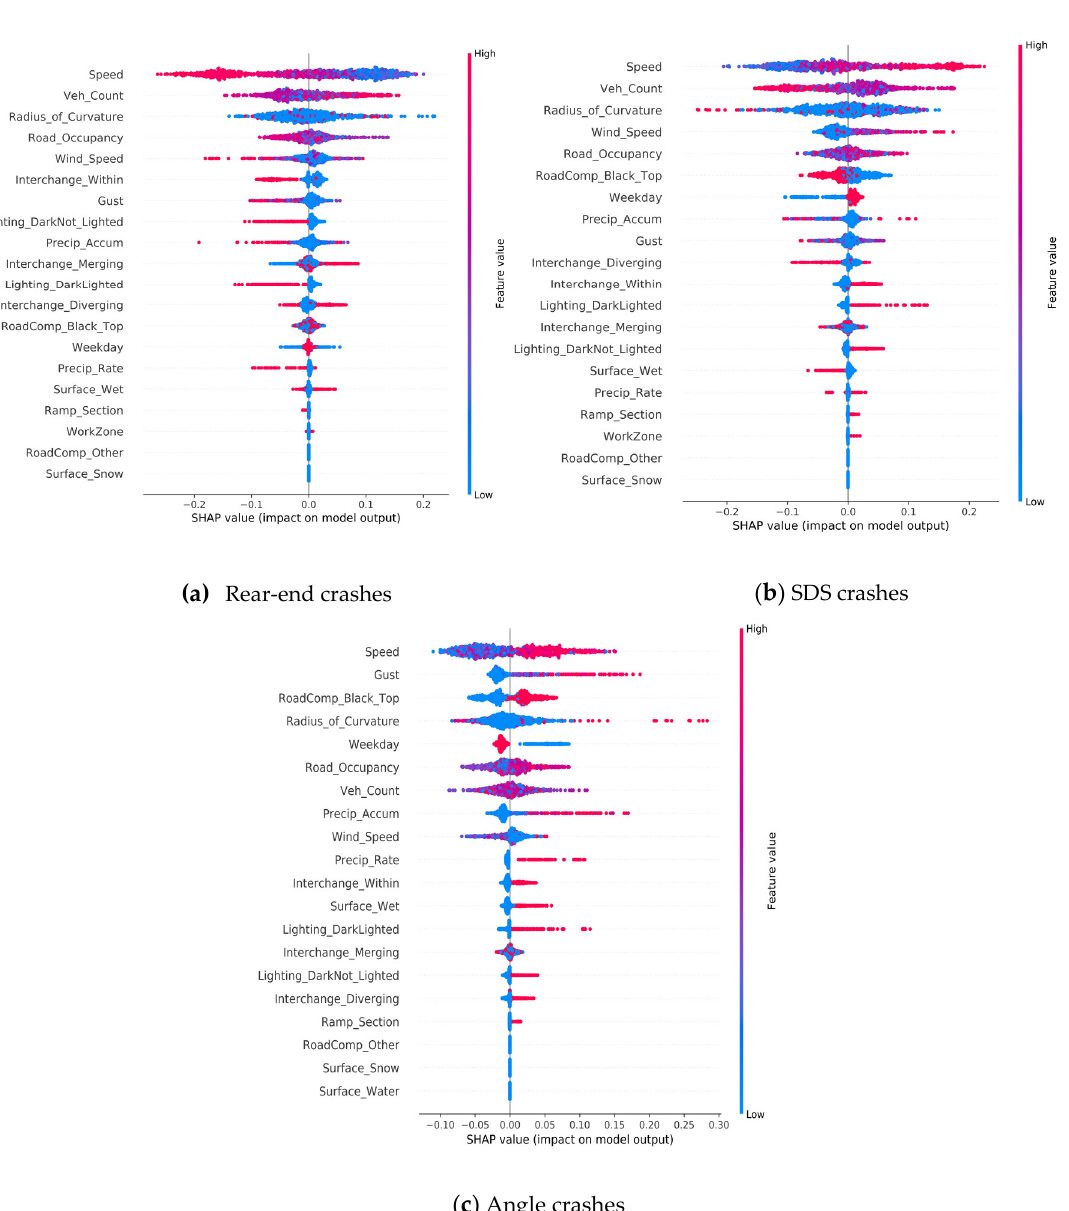
Figure 9. E ff ects of RTWE features; ( a ) SHAP value plot for rear-end crashes, ( b ) SHAP value plot for SDS crashes, ( c ) SHAP value plot for angle crashes (note: red indicates high feature value and blue indicates low feature value).